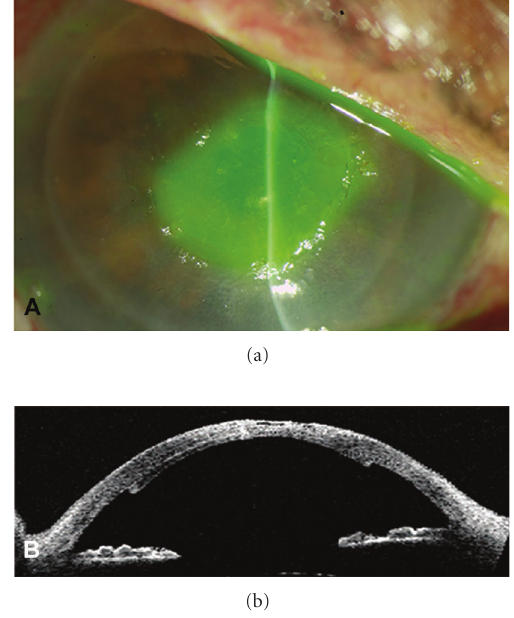
Figure 1: Day 1 postoperatively. (a) Slit lamp photography showing epithelial defect staining with fluorescein, mild corneal edema, and well-attached posterior lenticule. (b) Visante OCT showing epithelial defect, stromal thinning, and attachment of the posterior lenticule.